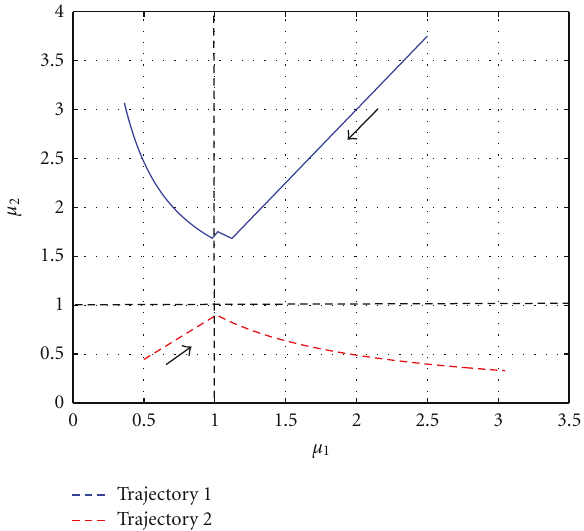
Figure 8: CDF of performance gain over the random Q values when system state is fully